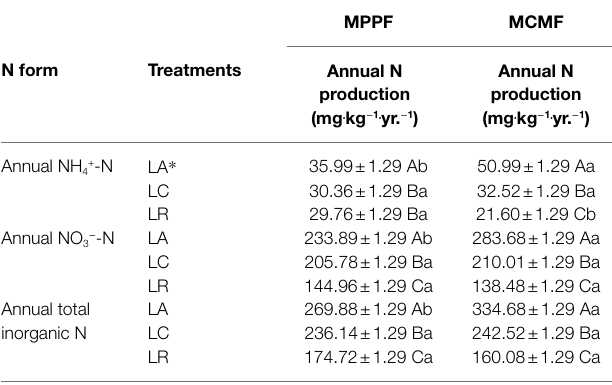
* LA, litter addition; LC, litter control; LR, litter removal; MPPF, Masson pine pure forests; MCMF, Masson pine and Camphor tree mixed forests. Values are mean ± SD. Different capital letters indicate significant differences among the treatments in the same forest type column. In contrast, lower-case letters indicate significant differences between the forest types under the same treatment (p <